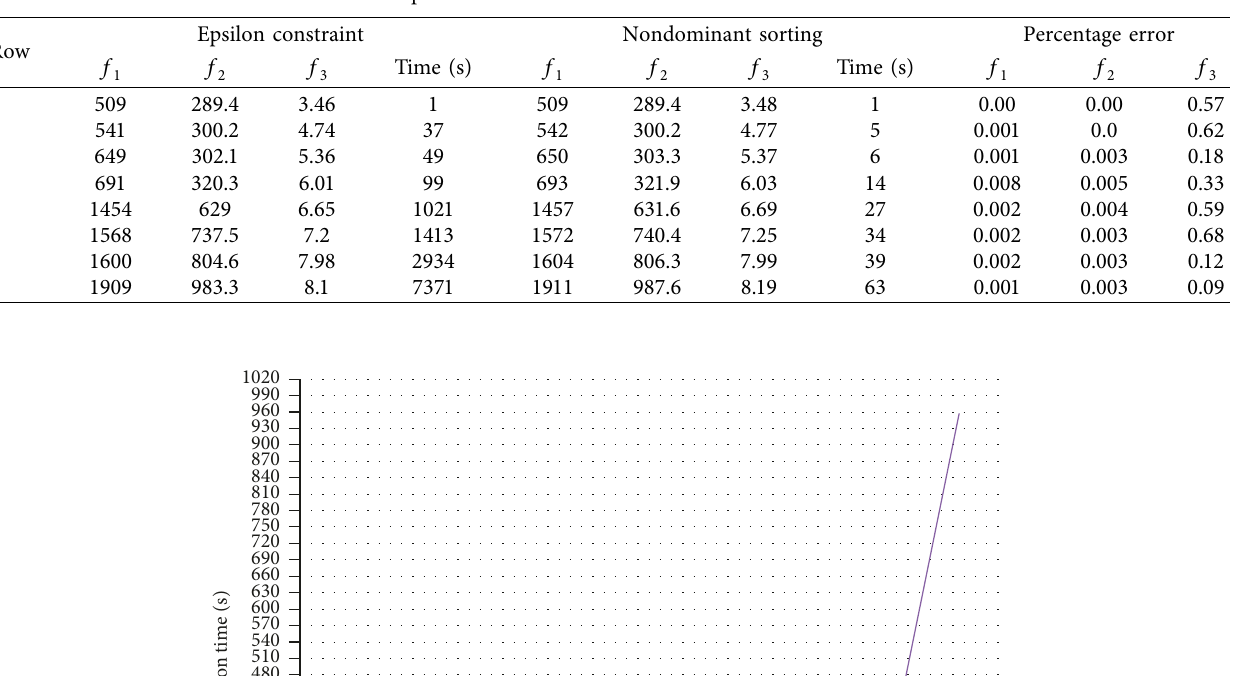
Table 5: Comparative results of solution for small and medium scales.